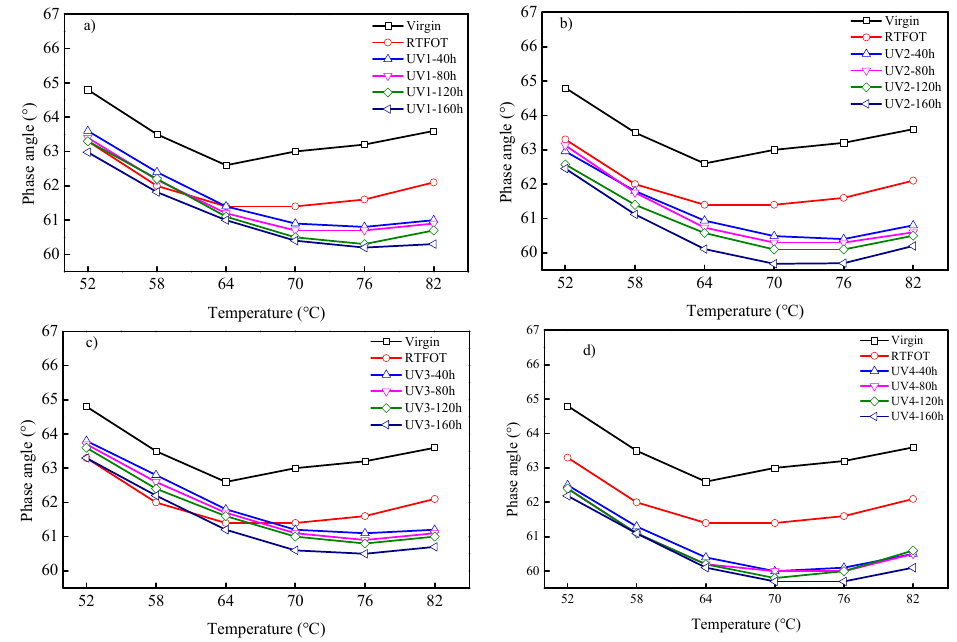
Figure 5. Phase angle of SBS-modified asphalt binders under different UV intensities: ( a ) UV = 5 mW/cm 2 ; ( b ) UV = 10 mW/cm 2 ; ( c ) UV = 15 mW/cm 2 ; ( d ) UV = 20 mW/cm 2. The phase angle represents the ratio of viscosity to elastic composition of the asphalt binder. The smaller the phase angle, the greater the proportion of the elastic component. It can be seen from Figure 5 that the phase angle of SBS-modified asphalt binders gradually decreases with increasing test temperature at the beginning, and then increases regardless of aging type and aging time, showing different characteristics to virgin asphalt binders. Generally speaking, with the increase of temperature, asphalt binders will gradually change from viscoelastic to viscosity properties, and the phase angle increases gradually. The reduction of phase angle at the beginning is mainly attributed